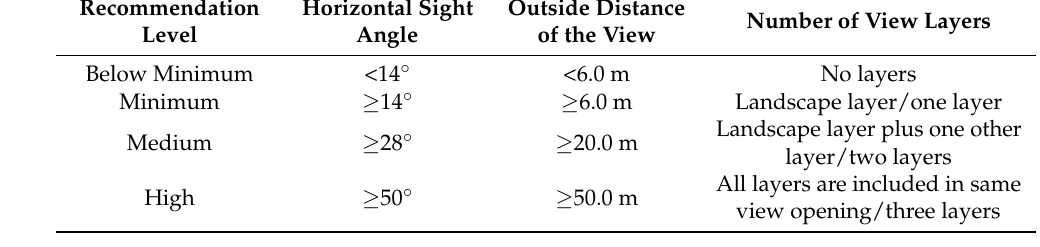
Table 1. Assessment of View Outwards—Information from EN17037.